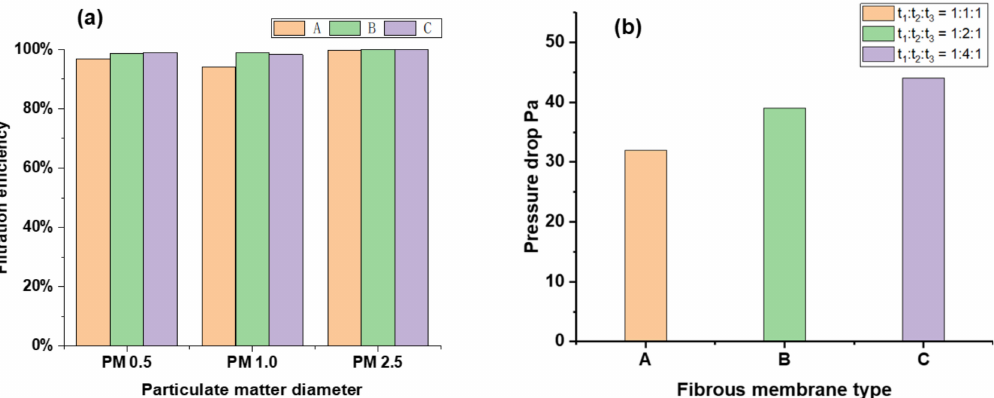
Figure 10. Filtration efficiency and pressure drop data of electrospinning nanofiber membrane particles under three spinning time ratios conditions A, B, and C. ( a ) Filtration efficiency of three composite nanofiber membranes for different particles; ( b ) Pressure drop of three composite nanofiber membranes.